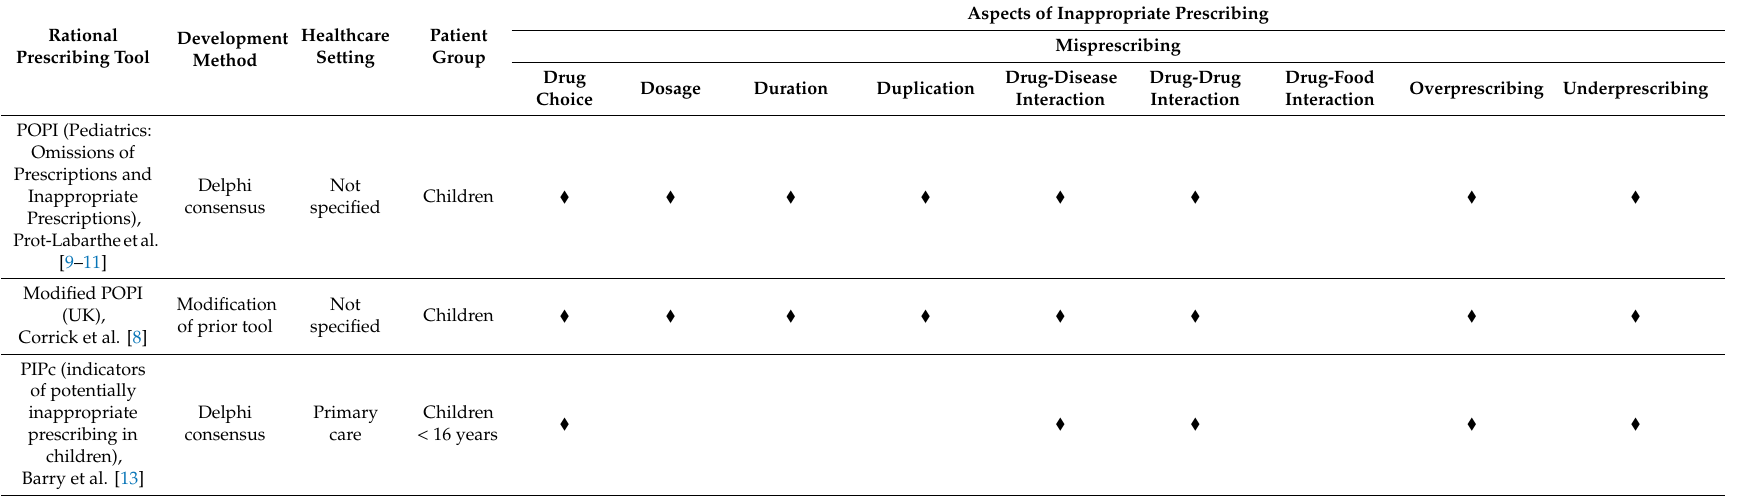
Table 2. Characteristics of the paediatric rational prescribing